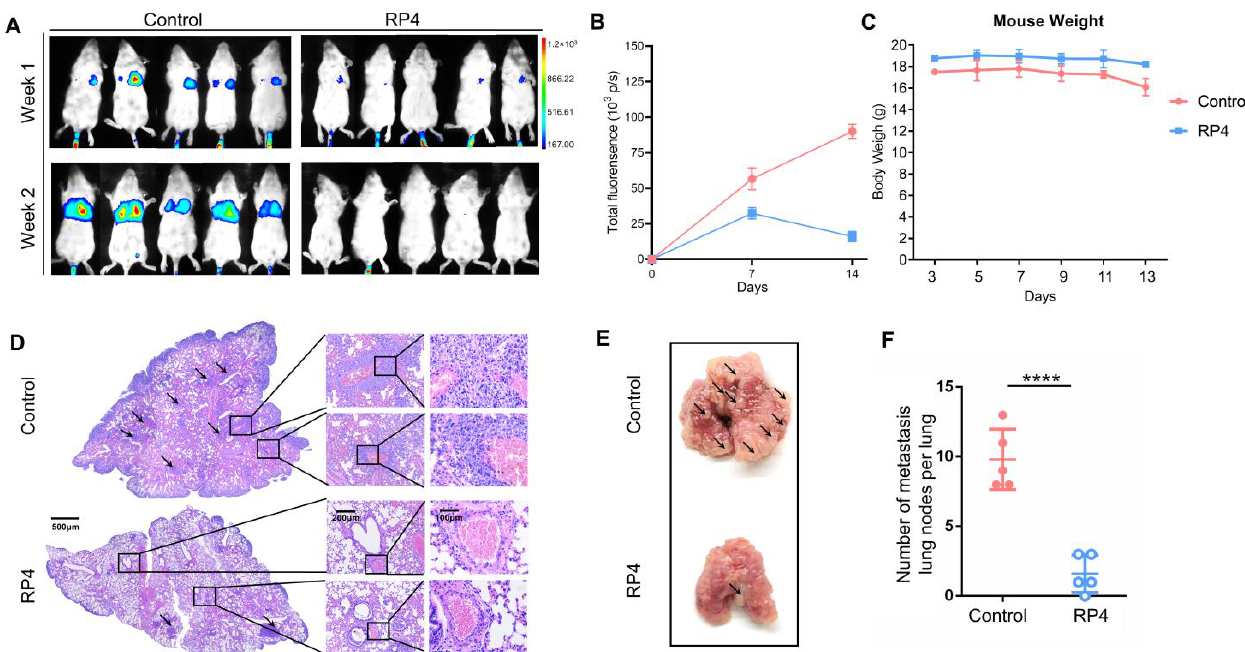
Figure 6. RP4 inhibits colorectal cancer lung metastasis in vivo. ( A ), Bioluminescence imaging of CT26 tumor-bearing mice injected with luciferase substrate. ( B ), Body weight curves ( n = 6). ( C ), Representative H&E stain showing the metastases area of the lung from CT26 tumor model. ( D ), Representative images of lung metastases in a CT26 tumor model. Arrows represent pulmonary nodules. ( E ), The representative image of lung with metastatic nodes. Arrows represent pulmonary nodules. ( F ), The statistic of metastatic lung nodes ( n = 6). Data are expressed as mean ± S.D. Statistical analysis was performed with t test ( n = 3; **** p < 0.0001). Representative images from three independent experiments are shown.